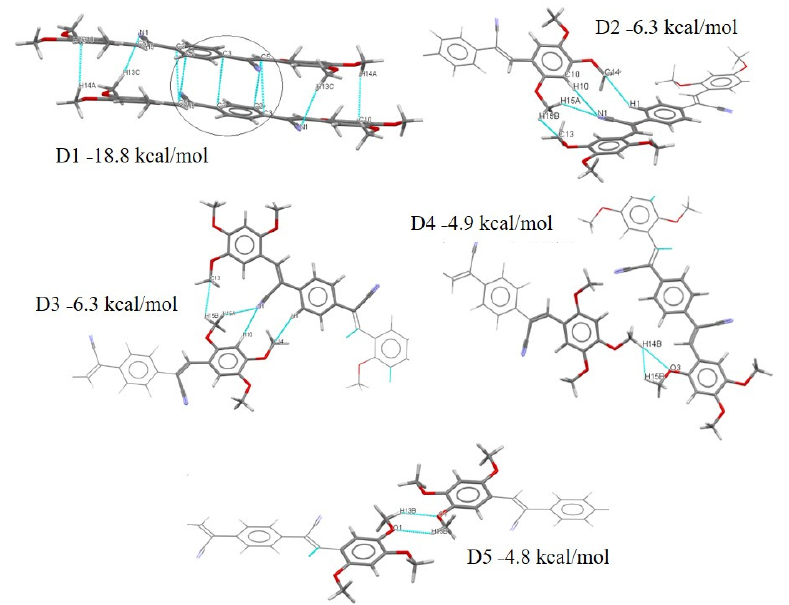
Figure 17. Different dimers (D1–D5) with interactions in the II crystal structure with respective interaction energies.